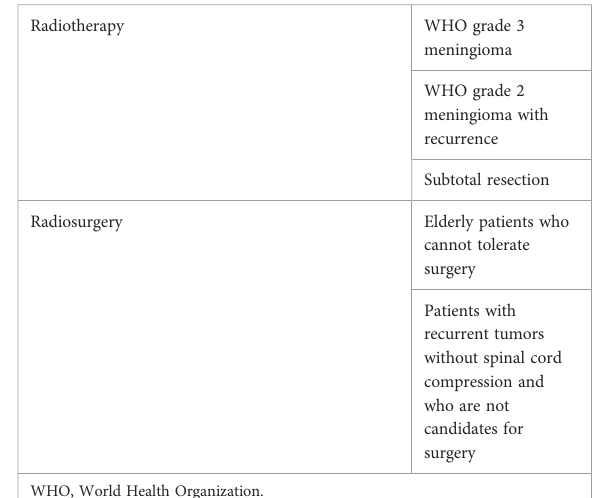
TABLE 6 Indication for adjuvant treatment in spinal meningiomas. TABLE 5 McCormick scale evaluating neurological outcomes in